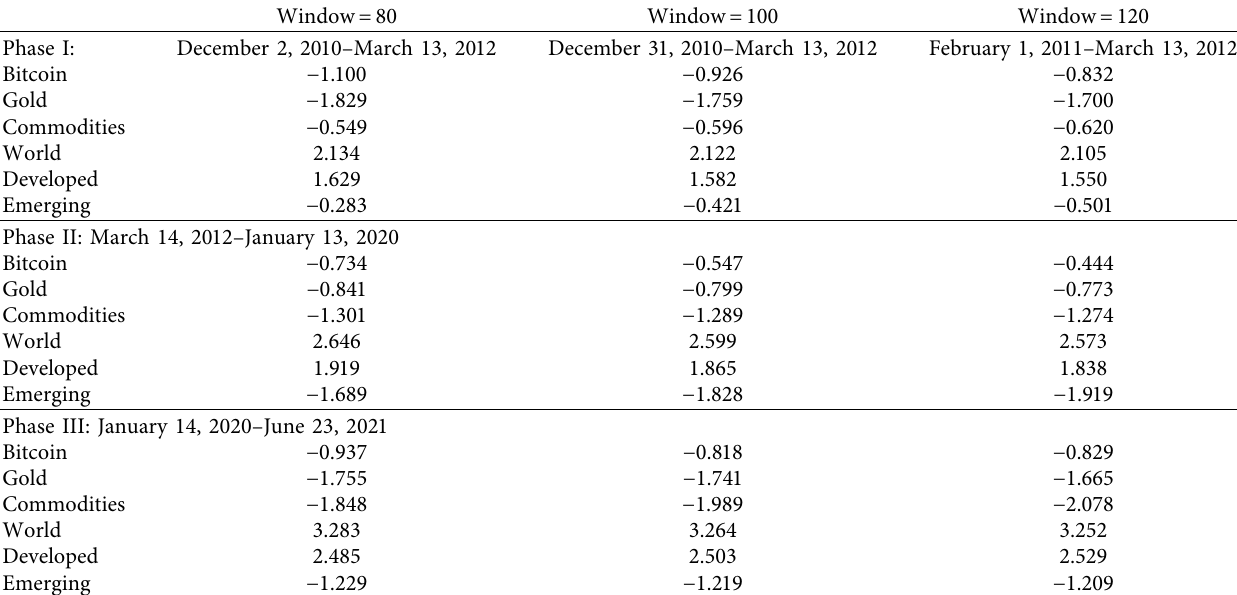
Table 3: Dynamic net spillover with different rolling windows.